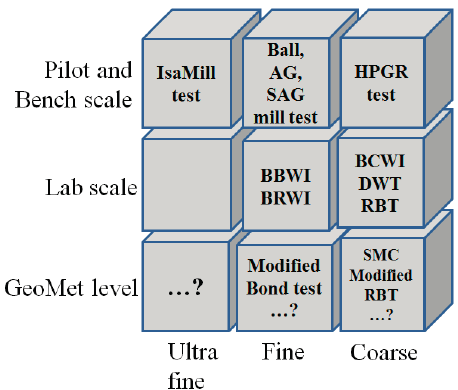
Figure 11. Comminution tests classified according to test design specifications. HPGR = High pressure grinding rolls; BBWI = Bond ball mill test; BRWI = Bond rod mill test; BCWI = Bond crusher test; DWT = Drop weight test; RBT = Rotary breakage tester; Modified RBT = Variation of the RBT (e.g., RBT lite) tester; Modified Bond = Variations of the Bond test; SMC = SAG Mill Comminution test; GeoMet level = Geometallurgical